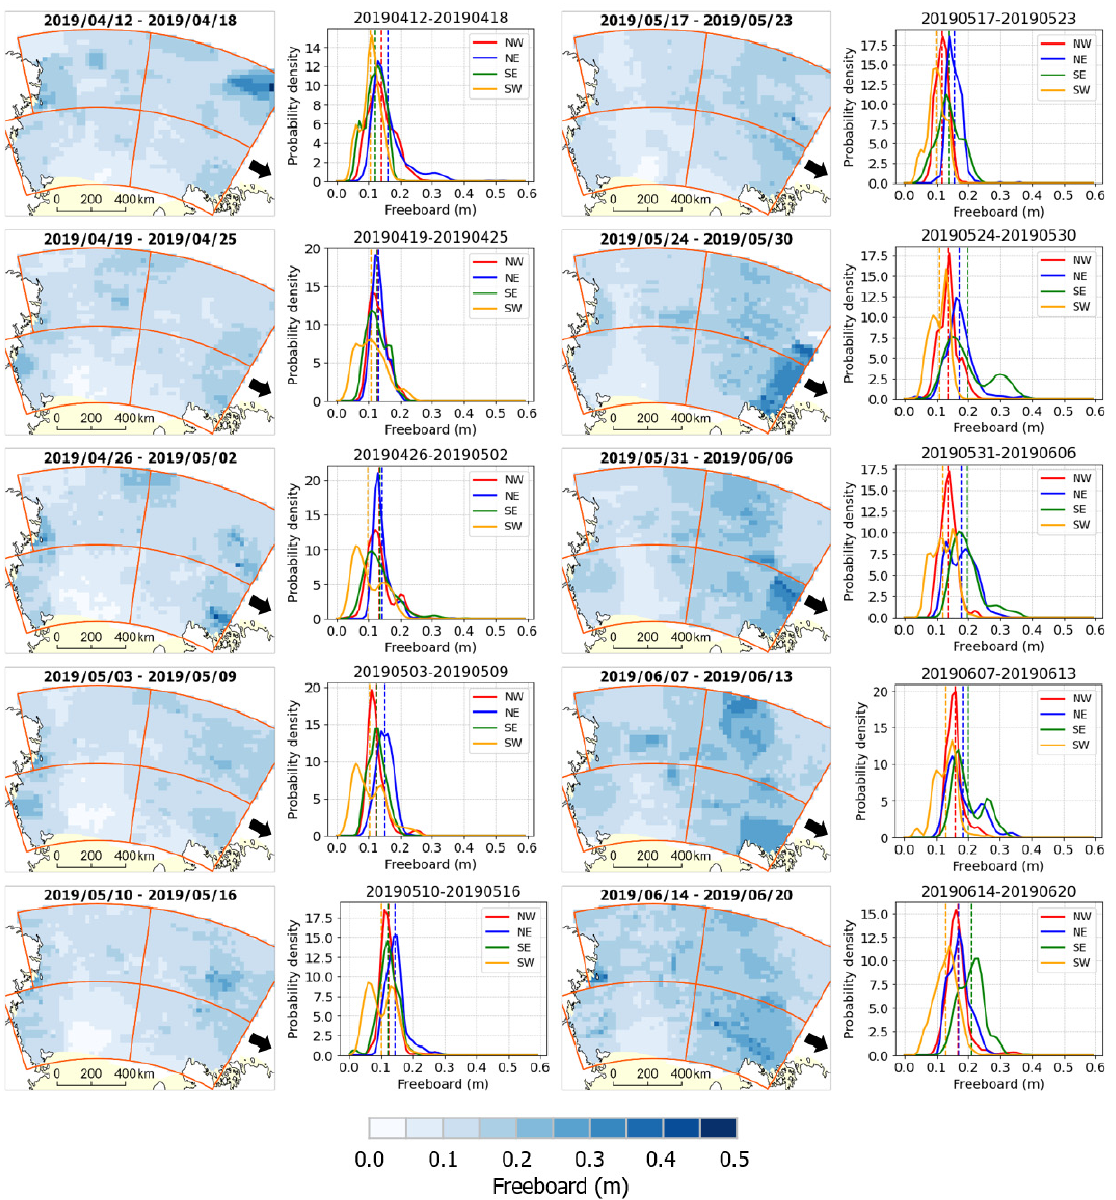
Figure 10. Weekly freeboard maps and freeboard distributions for the Ross Sea four sectors during April to June (slow- freezing season) 2019. Vertical dashed lines in the distributions indicate the mean of the freeboard for each sector. Black arrows on the maps indicate the location of the Amundsen Sea.